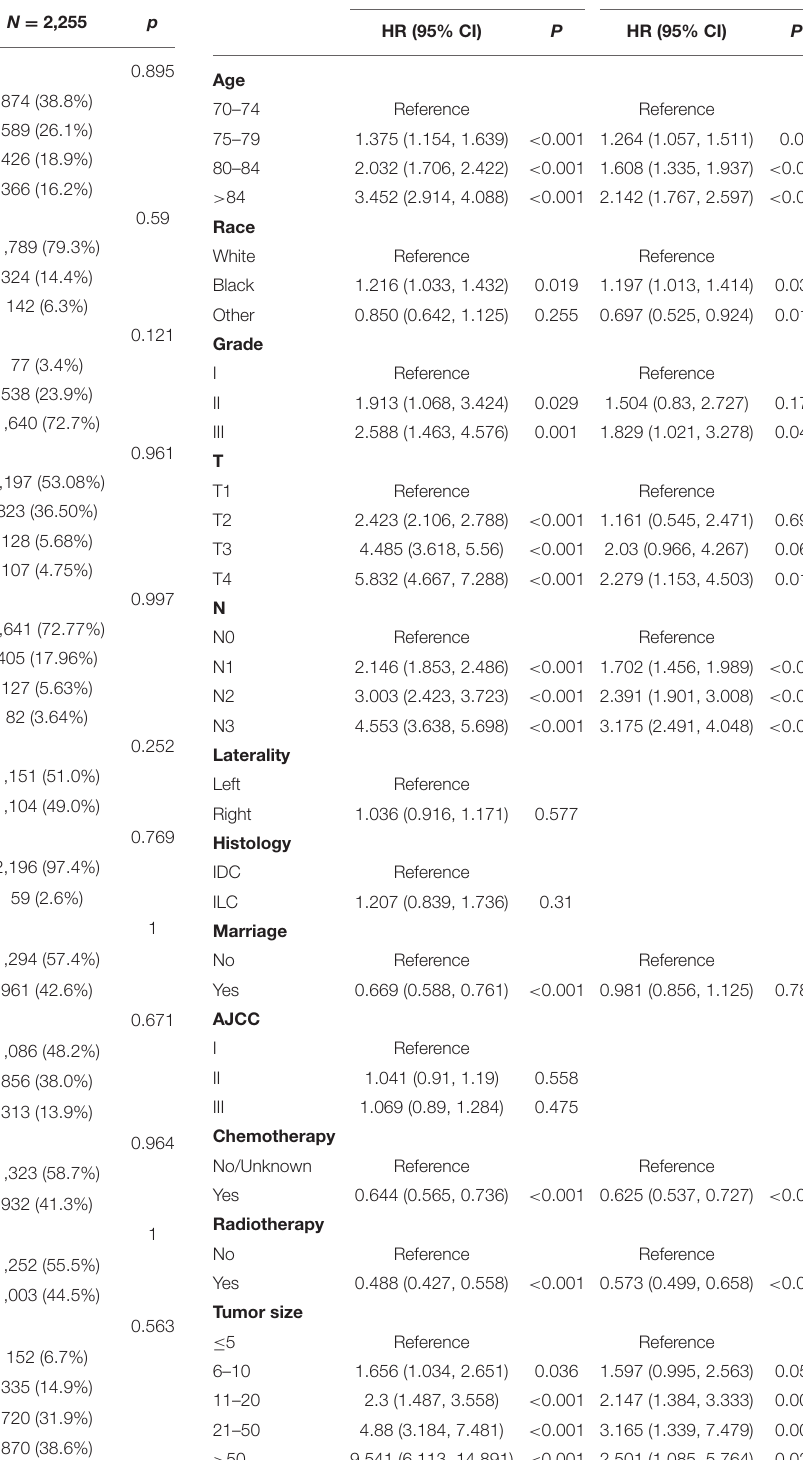
TABLE 2 | Univariate and multivariate analyses of overall survival (OS) in the current cohort. Variable Univariate analysis Multivariate